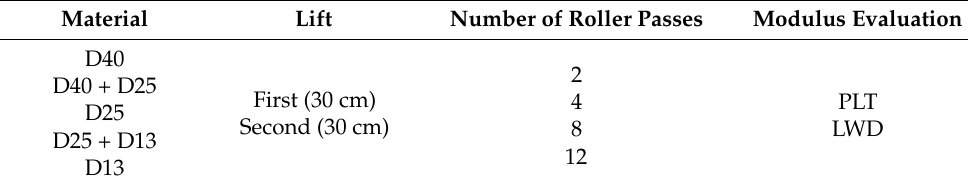
Figure 6. Layout of test locations for PLT [38]. 4. Modulus of Open-Graded Aggregate 4.1. Field Test Results Table 3 presents 80 cases of datasets including types of materials, the number of roller passes, and the moduli evaluated using PLT and LWD. E LWD is the elastic modulus meas- ured with the LWD test and E v1 and E v2 are the primary and secondary strain moduli, measured with the PLT test respectively. For each PLT, LWD tests were conducted twice, and therefore E LWD in the table is the average of two test results. There are five types of materials: D40, D40 + D25, D25, D25 + D13, and D13. Each of the materials is replaced with a numerical value of 1, 2, 3, 4, and 5, subsequently, to use as an input to the model. Areas A and B in Table 3 represent the test locations for PLT shown in Figure 5. In order to capture trends of the data in Table 3, it is also plotted in Figures 7–9.